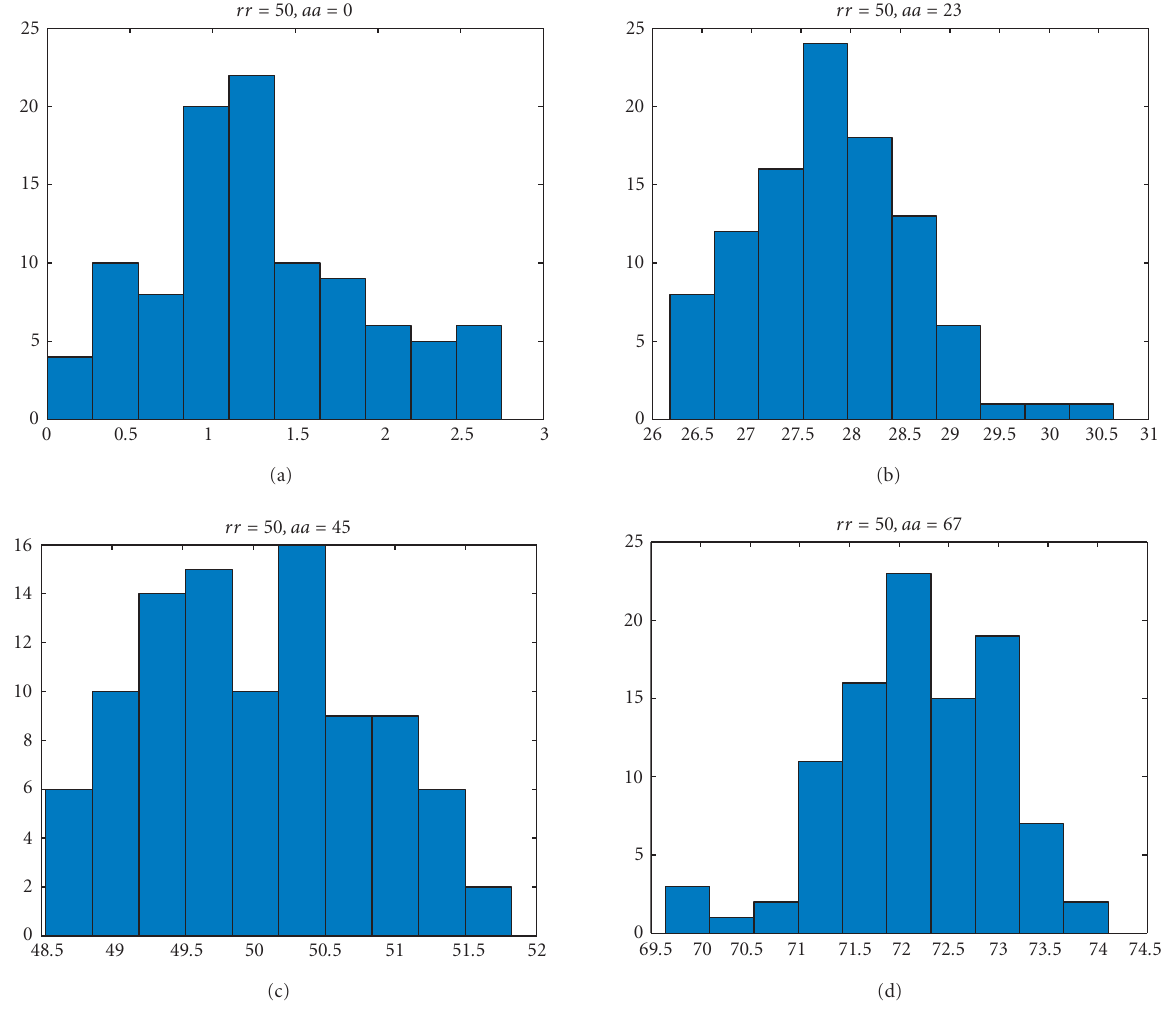
Figure 5: Histograms of the DOA estimate z at r = 50 feet and θ = 0 ,π/ 8 ,π/ 4, and 3 π/ 8 in (a), (b), (c), and (d),